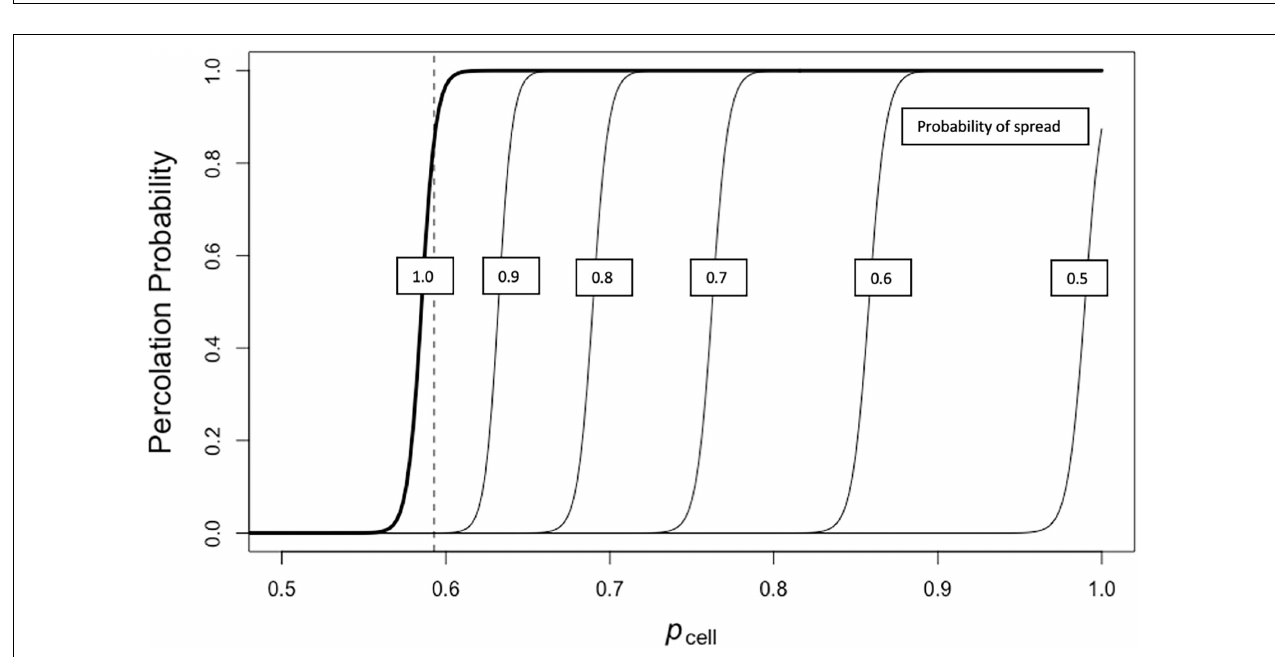
FIGURE 5 | Probability of fire percolation with landscapes of different size (Experiment E-1).